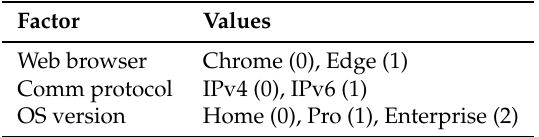
Table 1. Factors and values of a web browser-based software